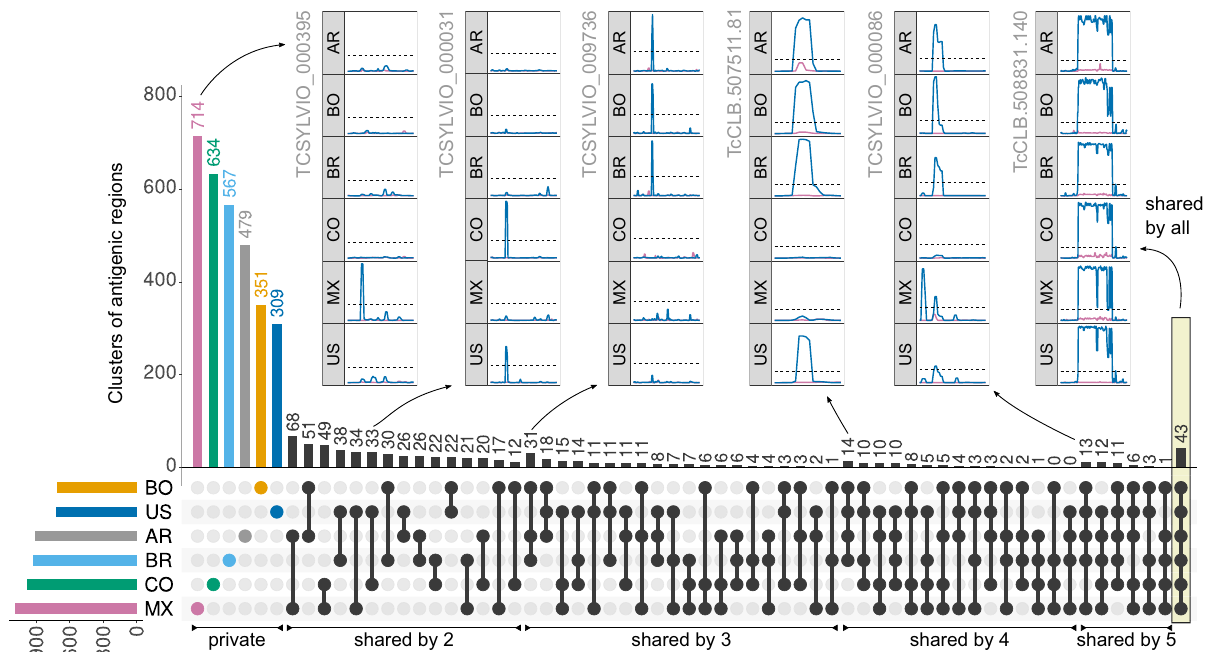
Fig. 3 | Diversity of T. cruzi antibody-speci fi c responses in pooled sera. Non- redundantclustersofreactiveregionsintheanalysed T.cruzi proteomes(clustered by sequence similarity) were counted on all intersections of the 6 analysed pooled samples. A cluster was antigenic in each sera pool when at least one of its regions wasantigenic in that pool.The UpSet Plot 73 displays a histogram with these counts